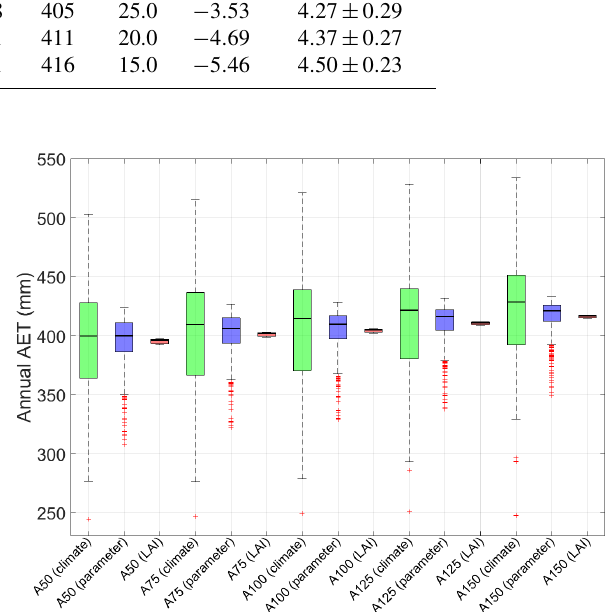
Figure 11. Box plots showing the distributions of annual AET ob- tained from the simulated water balances for the five illustrative covers with 700 parameter sets (blue boxes show parameter vari- ability) over a 60-year climate cycle (green boxes show climate vari- ability) with four LAI values (red boxes show LAI variability). The heavy dark line in each box plot shows the median, the boxes show the first and third quartiles, and the whiskers extend to 1.5 times the inter-quartile range. Outliers are shown as red plus